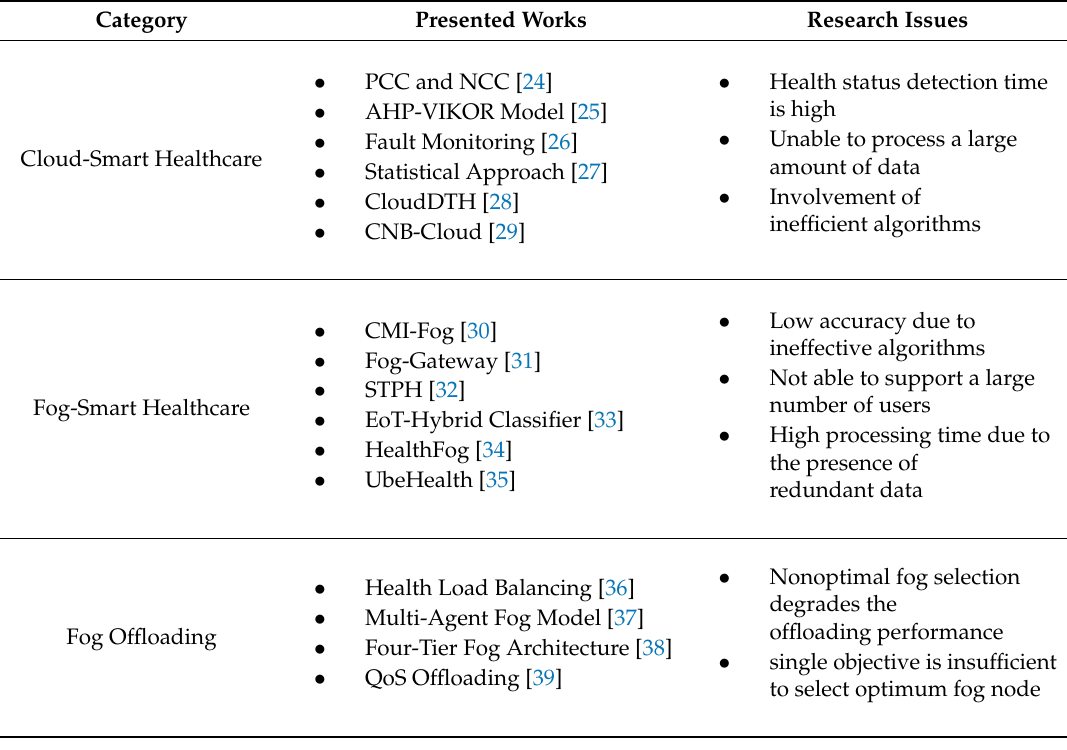
Table 1. Summarization of literature